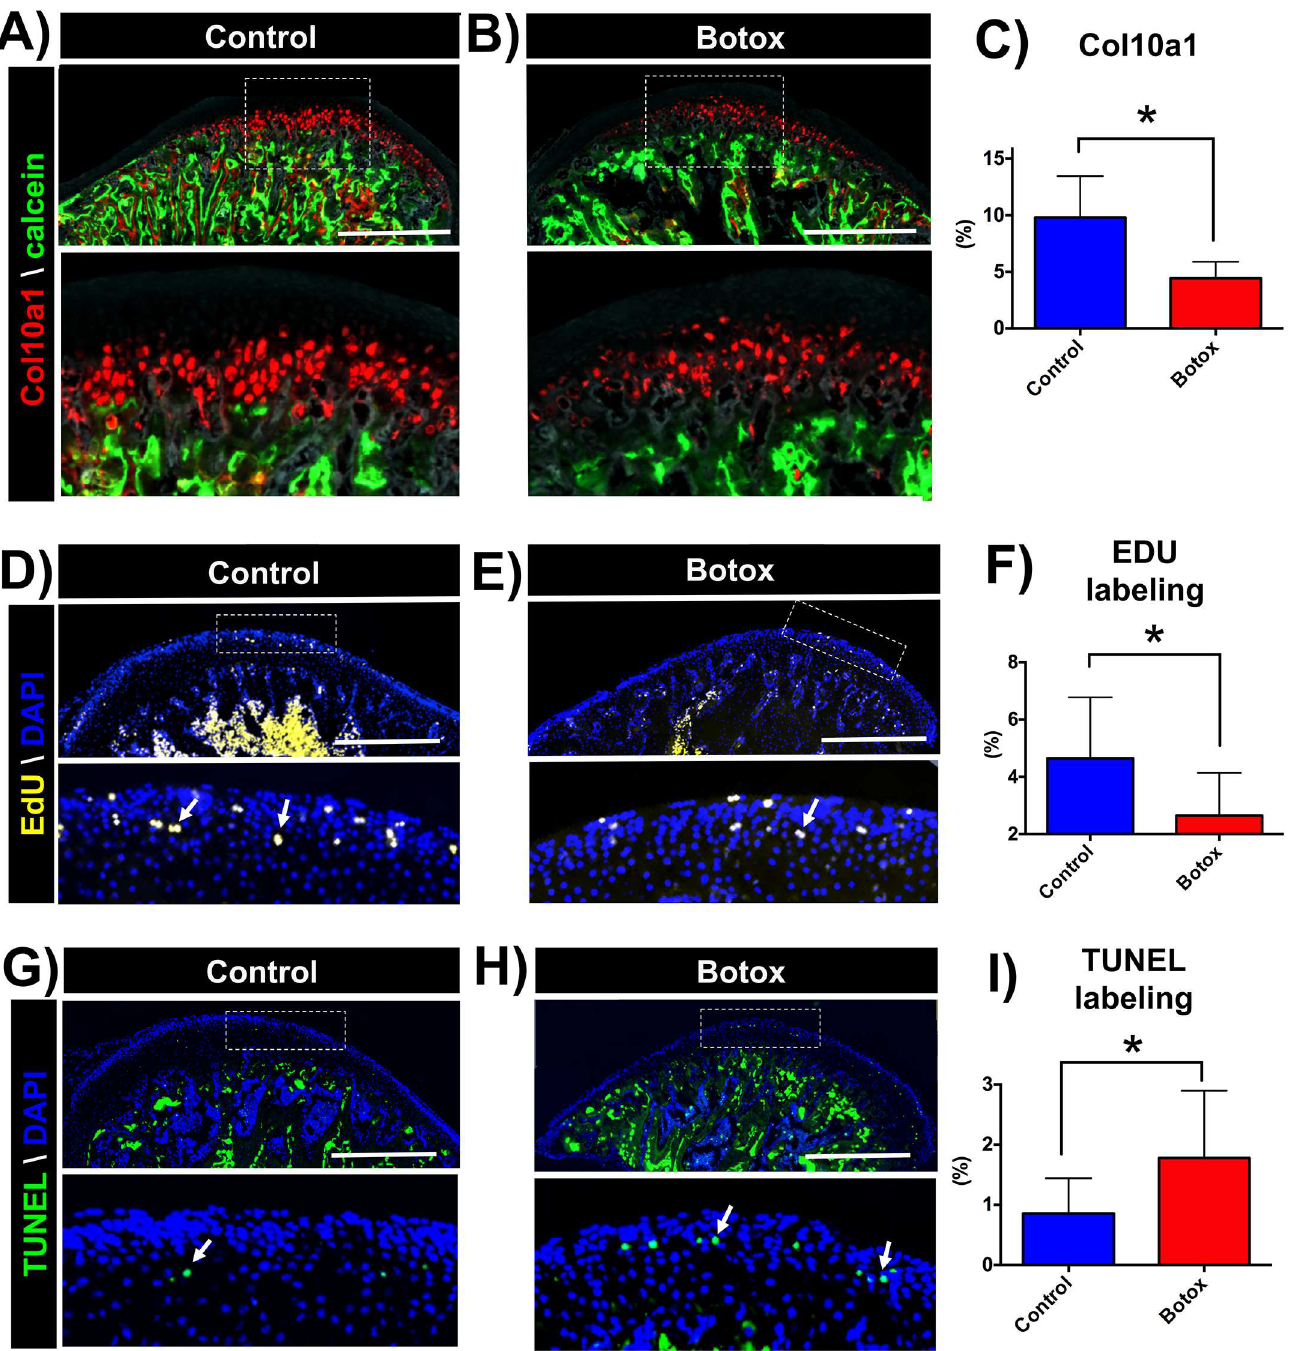
Fig 3. Reduced Col10a1 positive cells, decreased cell proliferation and increased cell apoptosis at the MCC of Botox injected side. Representative sagittal sections of condyles of transgenicmice (Col10a1-RFPcherry), control (A) and Botox (B) injected side. C) Quantification of Col10a1 positive pixels (red) over MCC area. Sagittal sections of control (D) and Botox (E) injected side condyles stained for EdU. F) Quantification of EdU positive pixels (yellow) over DAPI positive pixels (blue) at the proliferativezone. TUNEL staining in sections of control (G) and Botox (H) injected side condyles. Histograms (C-I) represents means ± SD for n = 7 (C-F) and n = 5 (I) per group . * Significant difference between control and Botox injected side (p < 0.05). Scale bar = 500 μ